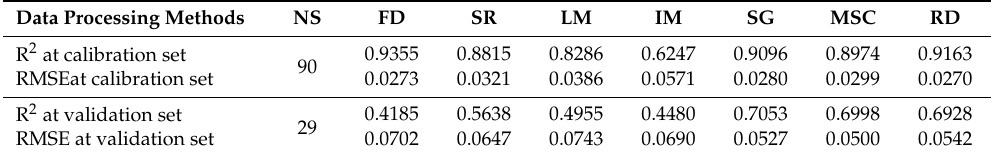
Table 1. PLSR pomelo water detection results after different data processing methods.